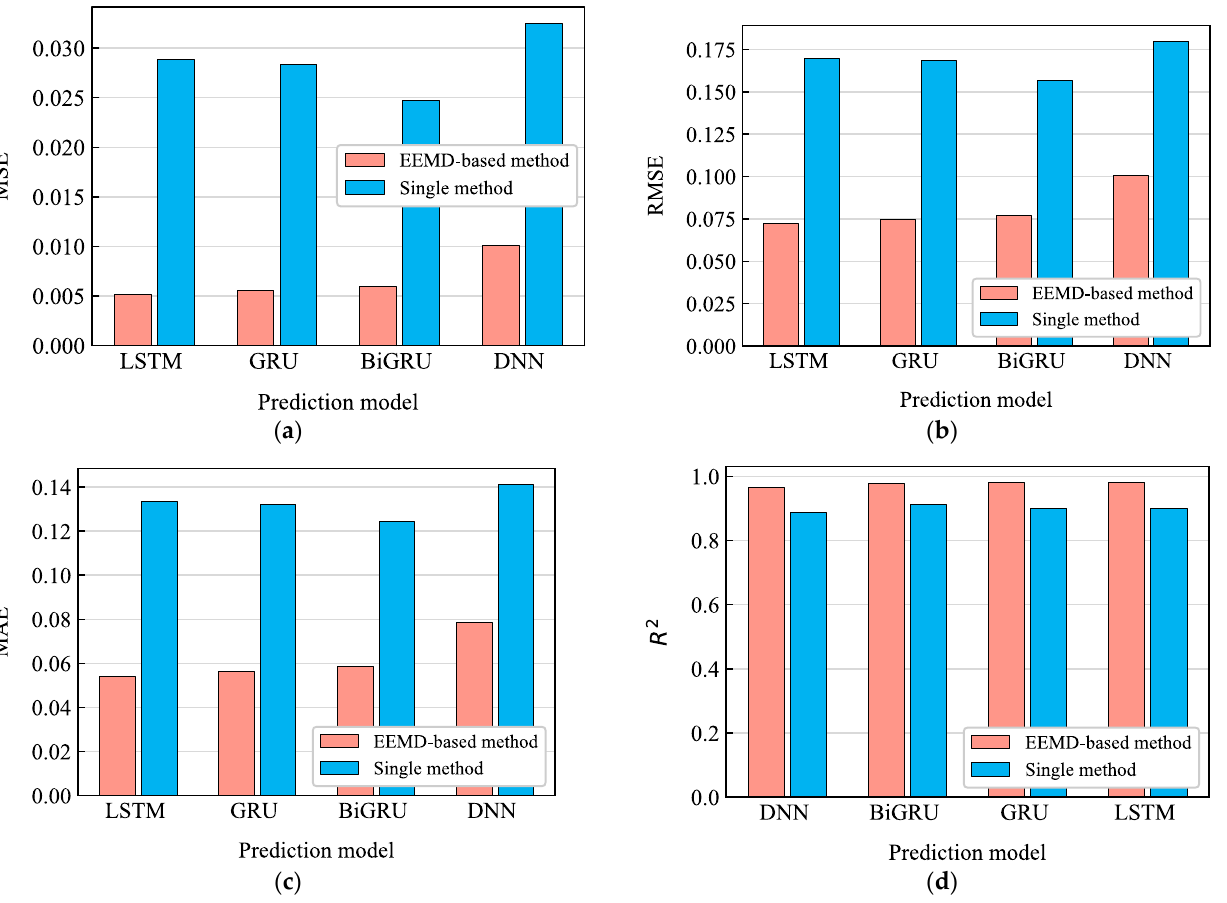
Figure 11. Predictive evaluation of hybrid EEMD-based methods with single methods: ( a ) mean squared error ( MSE ) of the different algorithms (white dataset); ( b ) root mean squared error ( RMSE ) of the different algorithms (white dataset); ( c ) mean absolute error ( MAE ) of the different algorithms (white dataset); ( d ) R 2 of the different algorithms (white dataset). Table 3. Multi-step prediction of the white